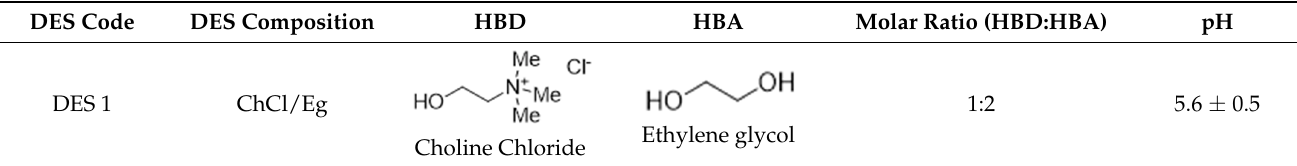
Table 1. Composition and pH of DES studied in this paper.